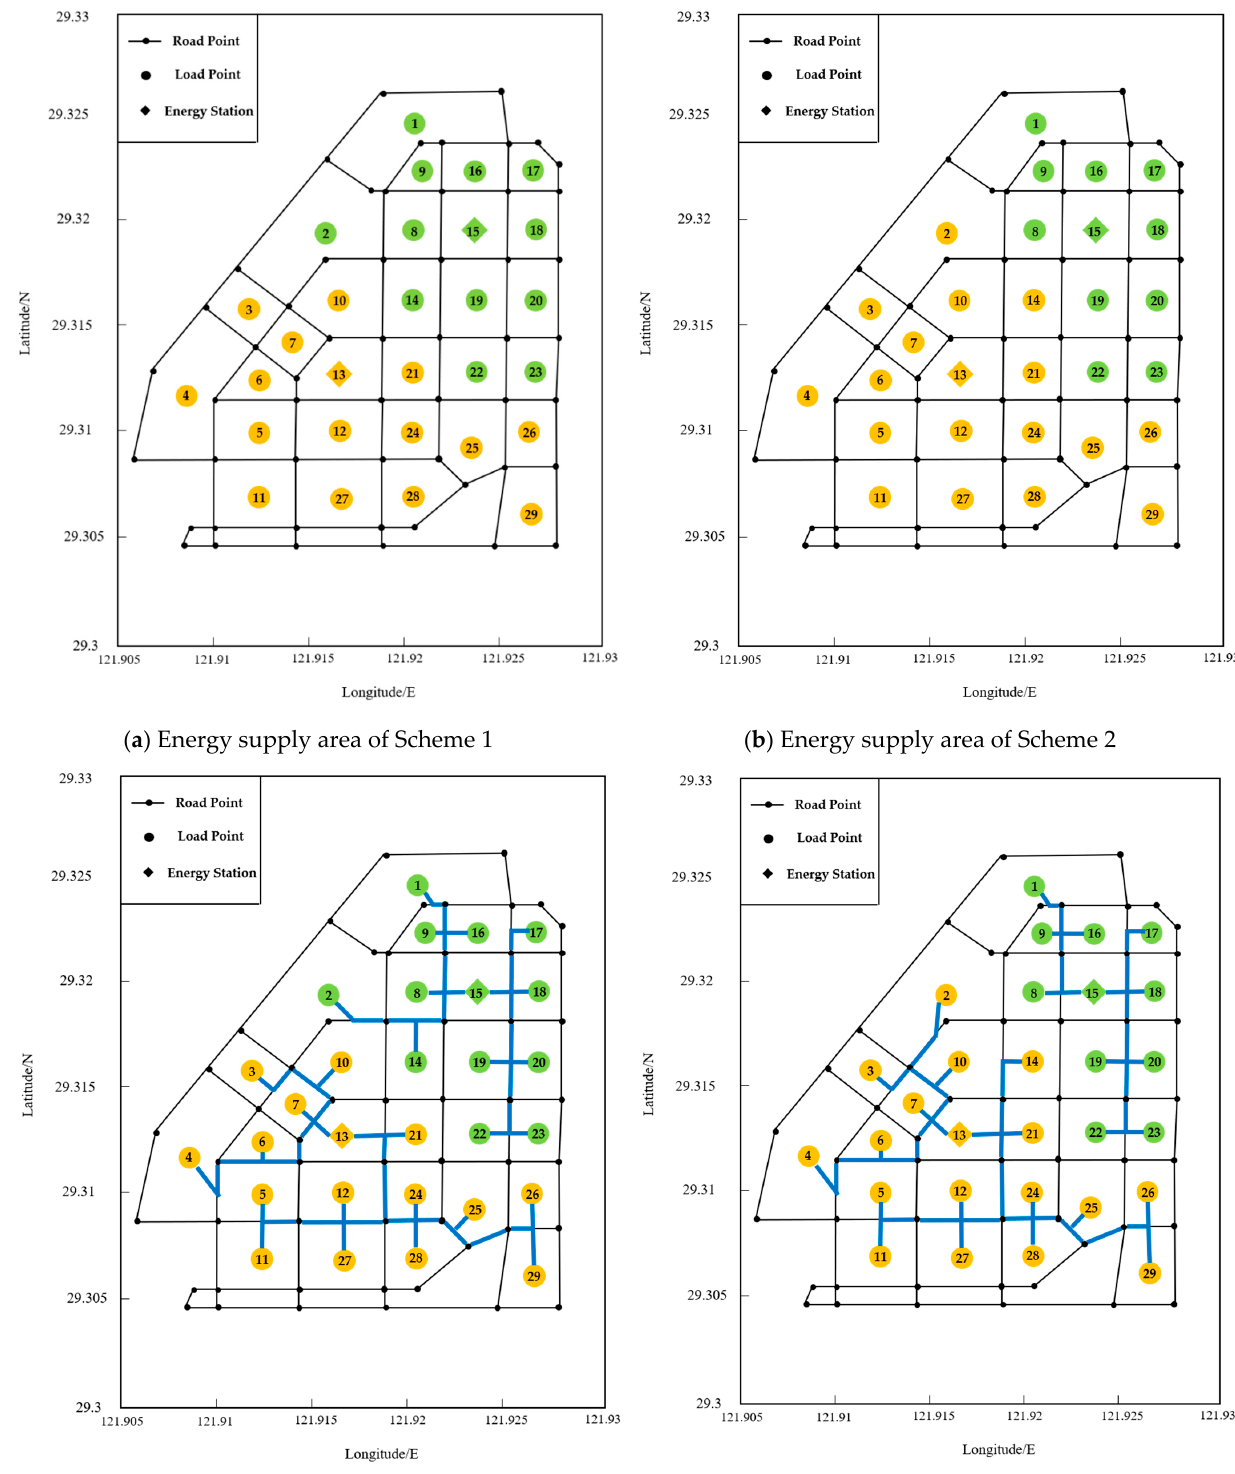
Figure 5. Station and network planning results of Scheme 1 and Scheme 2.